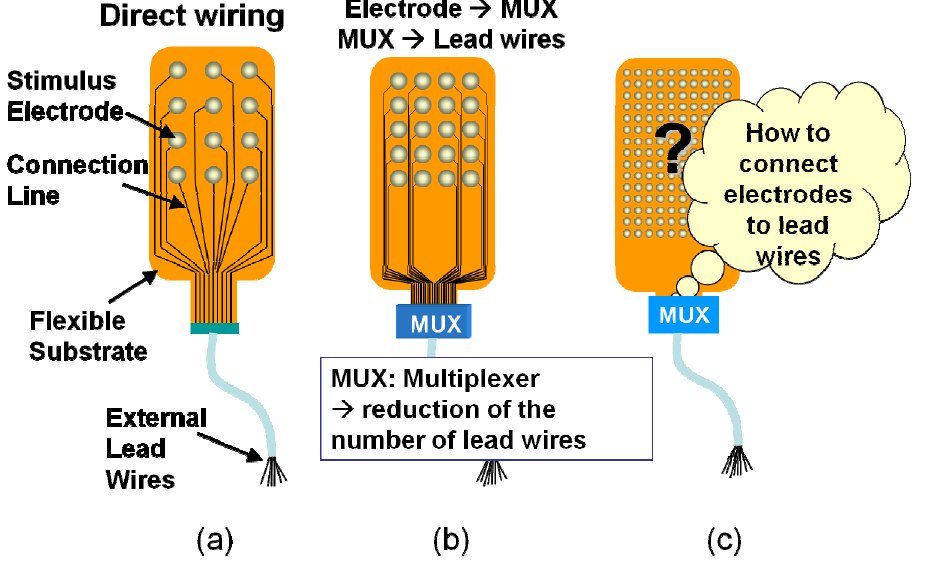
Figure 8. Problem of a large number of electrodes. (a) Direct wiring. (b) Embedding with MUX. (c) Large number of electrodes (adapted from [4]). MUX can reduce the number of external lead wires but not reduce the number of wires from electrodes to MUX.